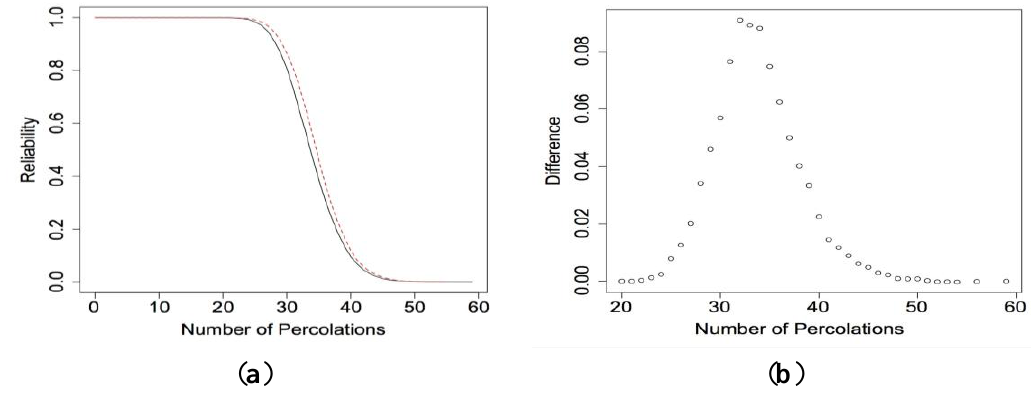
Figure 10. ( a ) R ( x ) calculated using our algorithm when the electrical current can 20 × 20 move in all directions (top curve) and when movement is restricted (bottom curve) when p = 0.98 and ( b ) the difference between the R ( x ). 20 × 20